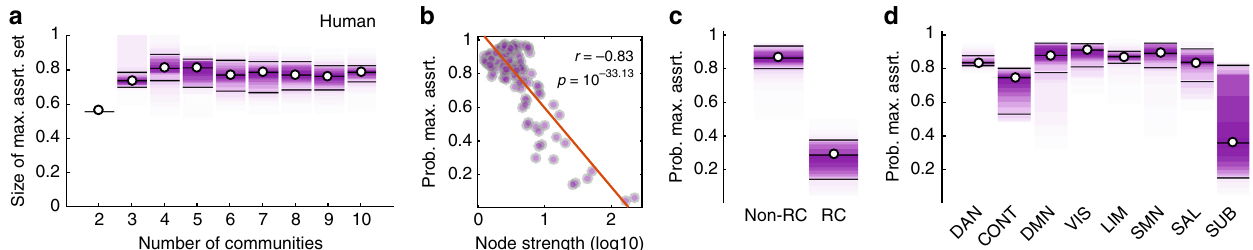
Fig. 4 Maximally assortative set. a Fraction of brain regions comprising the maximally assortative set as a function of the number of communities. b High strength nodes are less likely to participate in the maximally assortative set. c As a consequence, the maximally assortative set is comprised mostly of non- rich club brain regions; RC, rich club. d At the system level, control and subcortical networks are the least likely to participate in the maximally assortative set. DAN, dorsal attention; CONT, cognitive control; DMN, default mode; VIS, visual; LIM, limbic; SMN, somatomotor; SAL, salience; SUB, subcortical